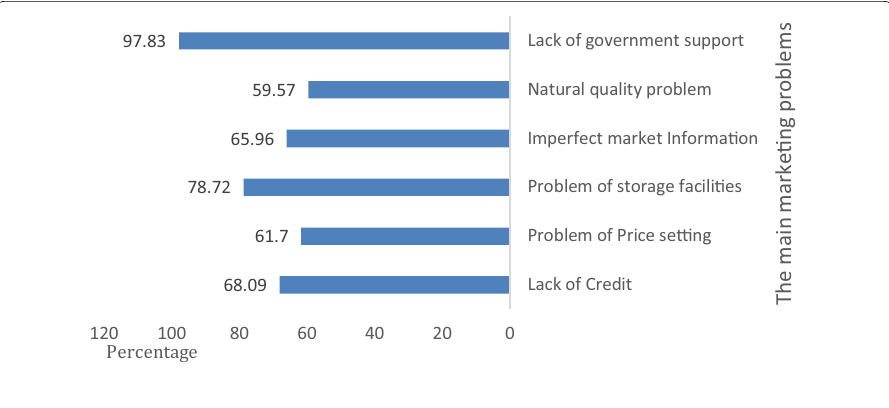
Fig. 4 Marketing problems faced by pepper producers. *Multiple